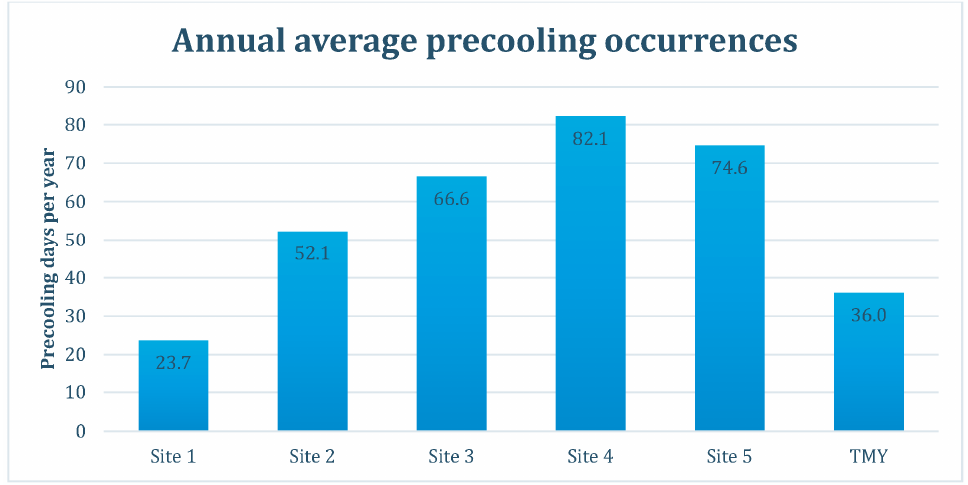
Figure 4. Average number of days that precooling conditions are met across the five Sydney sites. Table 6. Comparison of distribution of precooling